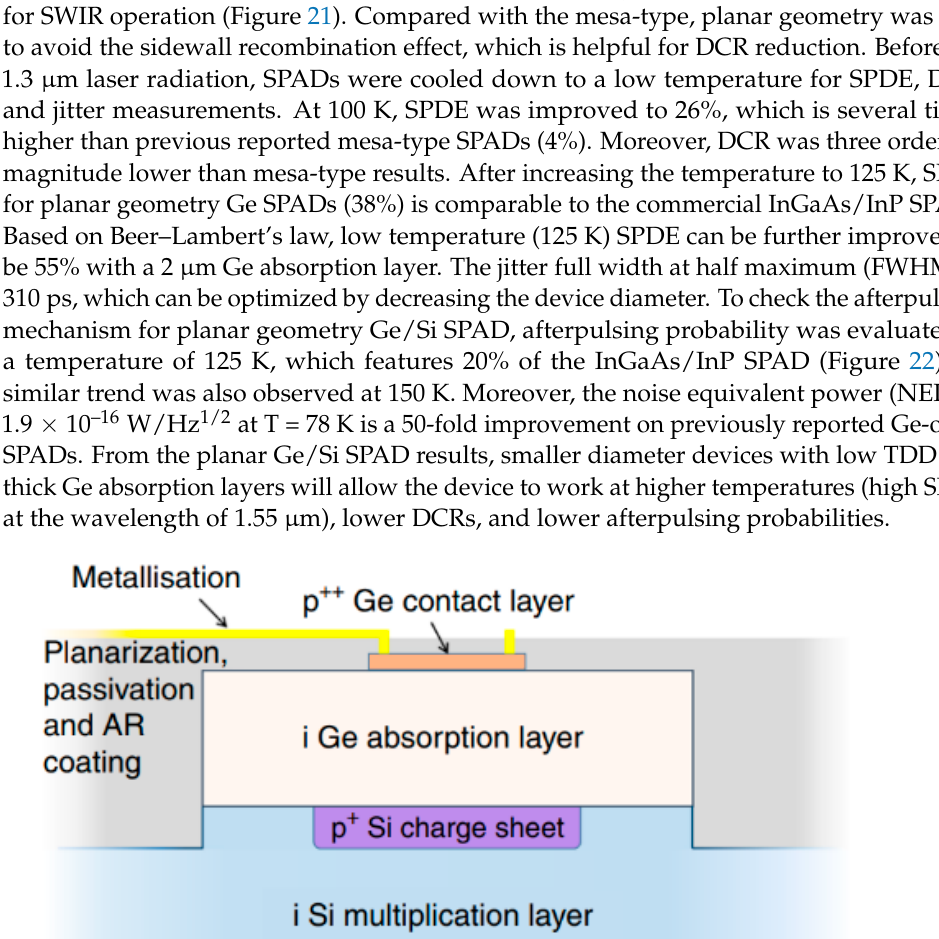
Figure 22. Comparison of afterpulsing probabilities vs. gate delay time between planar Ge/Si SPAD (100 μ m diameter) with commercial InGaAs/InP SPAD (25 μ m diameter). Reproduced from [78], Springer Nature, open access, 2019. To further decrease the DCRs of 100 μ m diameter planar geometry for Ge/Si SPAD, device diameters were fabricated to be 26 μ m and 50 μ m. Device performance for the Ge/Si SPAD with different diameters was summarized as follows: in terms of tempera- ture, SPDE, DCRs, Jitter, and NEP (Table 2). It was found that an extremely low DCR was achieved for the 26 μ m diameter detector, indicating excellent sensitivity for planar ge- ometry Ge/Si SPAD. Although the maximum SPDEs of the 26 μ m and 50 μ m devices were 10% lower than those of the 100 μ m device, jitter and the NEP for the 26 μ m device were 157 ± 10 ps and 9.8 × 10 –17 WHz − 1/2 , respectively. The 26 μ m diameter device shows record- low NEP, which suggests planar geometry has the potential to achieve low-cost and high- speed Ge/Si SPAD arrays in the SWIR spectral region. Compared with the commercial InGaAs/InP SPAD, the Ge/Si SPAD features lower DCRs and shorter data acquisition times. Table 2. Summarized device performance for planar geometry Ge/Si SPAD at 1.31 μ m [77–79].